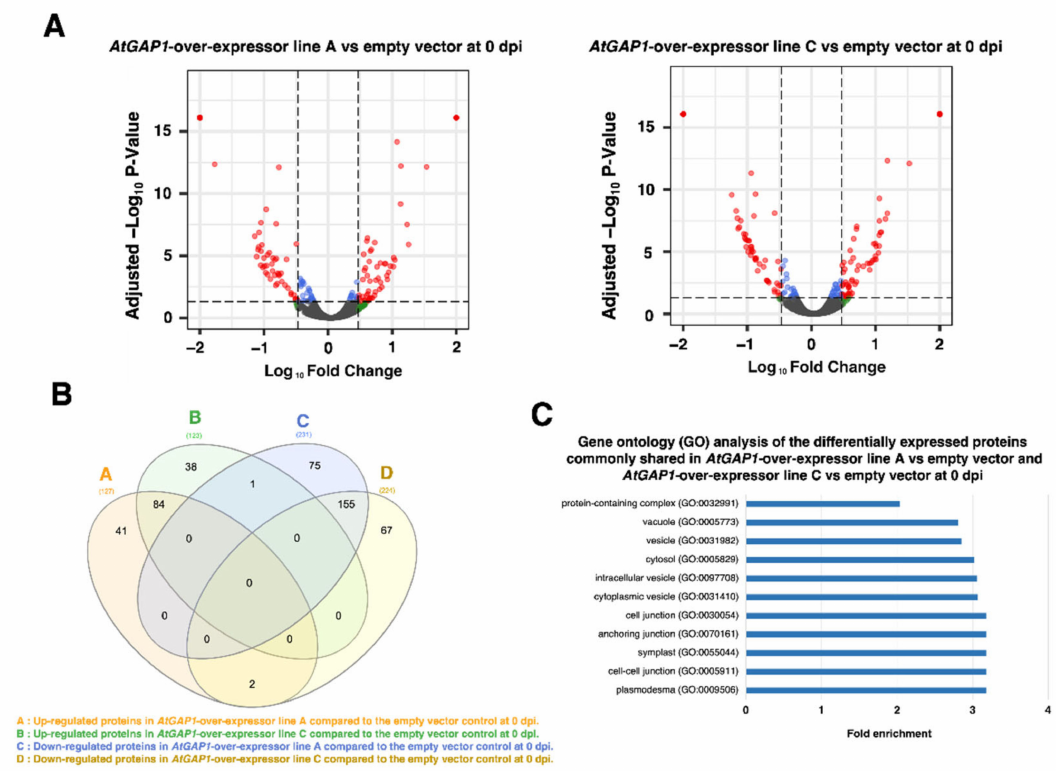
Figure 4. Differential protein expression profiles due to AtGAP1 -overexpression in Arabidopsis at Day 0 of Pst DC3000 inoculation analyzed by liquid chromatography-mass spectrometry (LC-MS) and label-free quantification (LFQ). ( A ) Volcano plots showing the fold changes in proteins in AtGAP1 -overexpressor A and AtGAP1 -overexpressor C compared to the empty vector control at Day 0 of Pst DC3000 inoculation (0 dpi). The data from LFQ were subjected to Student’s t-test based on the default parameters in Proteome Discoverer v2.4 (Thermo Fisher Scientific, Waltham, MA, USA). Differentially expressed proteins with Benjamini–Hochberg adjusted p -value < 0.05 and log 10 (|fold-change|) > 0.48 (equivalent to 3-fold changes) were plotted in red. Proteins with log 10 (|fold change|) > 0.48 but with adjusted p -value ≥ 0.05 were plotted in green, and those with log 10 (|fold change|) ≤ 0.48 with adjusted p -value < 0.05 were plotted in blue. ( B ) Venn diagram showing the numbers of differentially expressed proteins common between AtGAP1 -overexpressor A and AtGAP1 -overexpressor C when compared to the empty vector control at 0 dpi. ( C ) Gene ontology (GO) analysis of the 239 differentially expressed proteins having similar expression trends in both AtGAP1 -overexpressors A and C compared to the empty vector control at 0 dpi. The differentially expressed proteins were classified using PANTHER from The Arabidopsis Information Resources (TAIR) database for the GO-term enrichment in cellular components. GO-terms with fold enrichment > 2 and Bonferroni-corrected p < 0.05 were listed. The results were the average of three biological replicates analyzed using Proteome Discoverer v2.4 (Thermo Fisher Scientific, Waltham, MA, USA). For each biological replicate, three plants were collected for protein